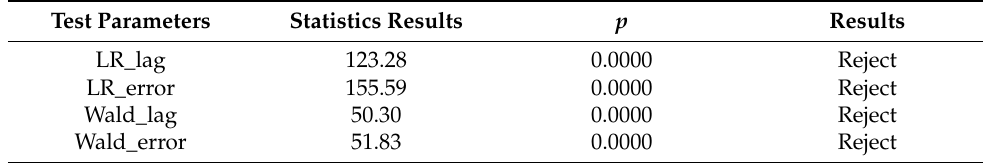
Table 4. Statistical tests for spatial Durbin model selection.